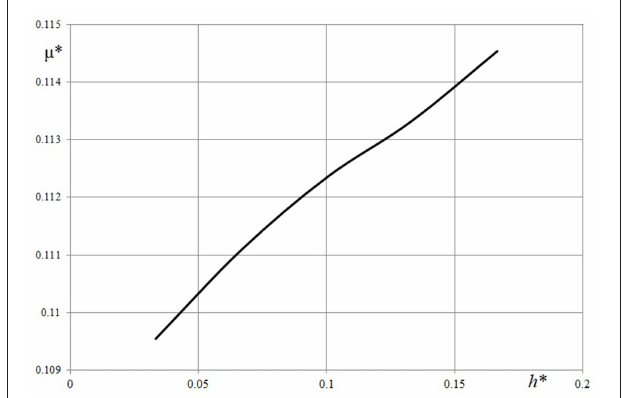
FIGURE 6 | Dependence of friction coefficient on layer thickness ( c = 5; ν = 0.3; Q ′ = 0.01).